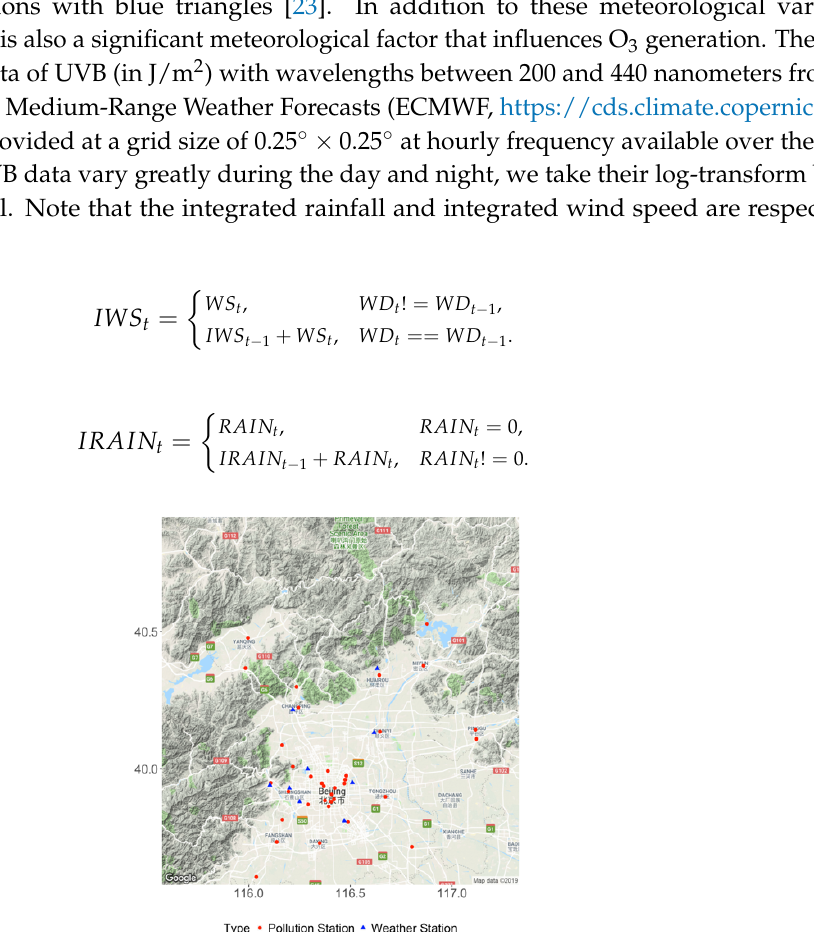
Figure 1. Thirty-six air quality monitoring stations with red dots and nine meteorological stations with blue